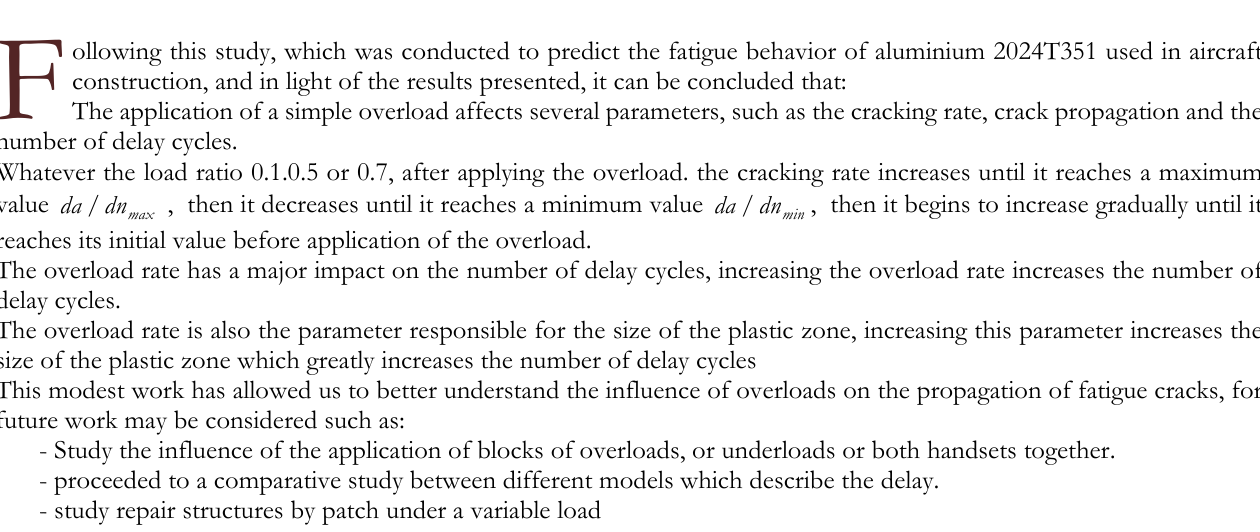
C ONCLUSION AND